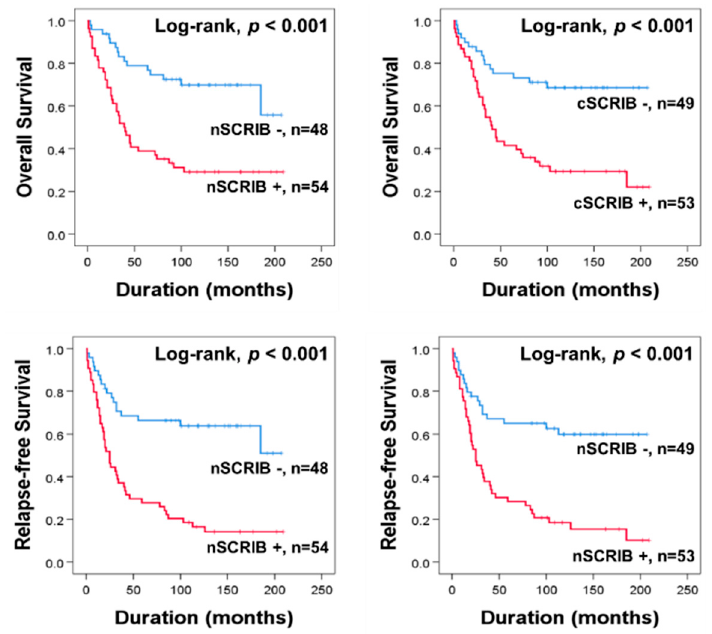
Figure 2. Kaplan-Meier survival curves according to the nuclear and cytoplasmic expression of SCRIB in 102 ovarian carcinoma patients. In addition, we performed survival analysis according to histologic subtype of ovarian carcinomas. In high-grade serous carcinoma (HGSC), age, cancer stage, and nSCRIB were significantly associated with OS or RFS in univariate analysis (Table 3) (Figure 3A). In addition, despite the low number of cases, nSCRIB and cSCRIB were significantly associated with survival of mucinous carcinoma patients (Figure 3B).